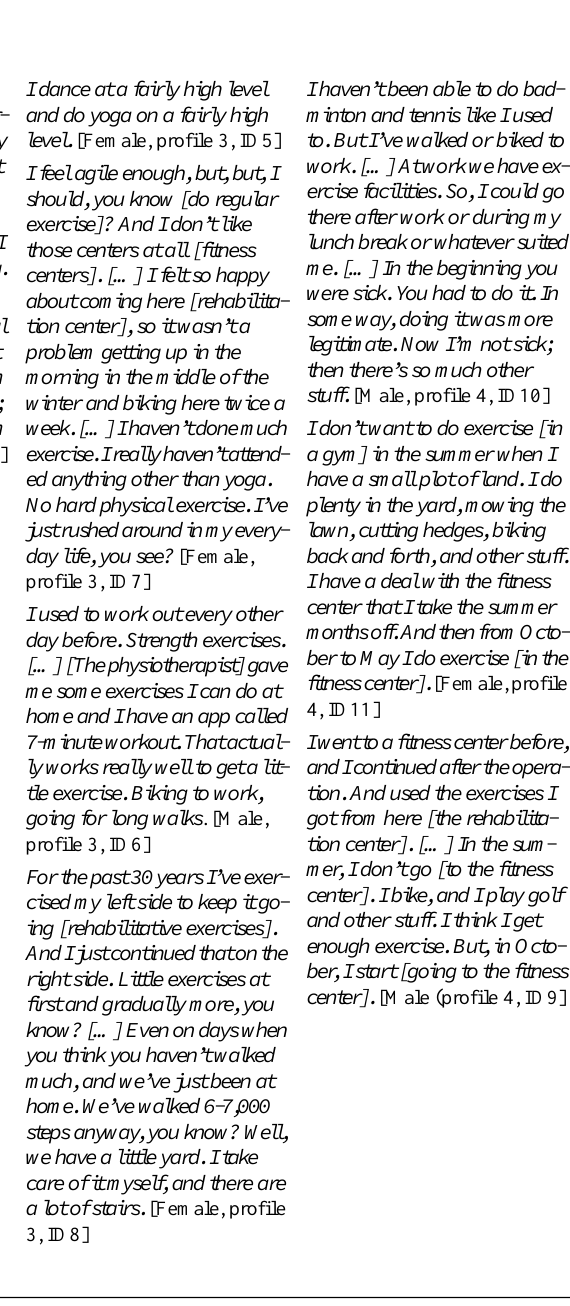
Table 2. Quotes illustrating the “attitude toward physical activity” and “attitude toward technology-assisted physical activity” themes. subcategories Attitude toward physical activity Incidental or structured (exercise) physical